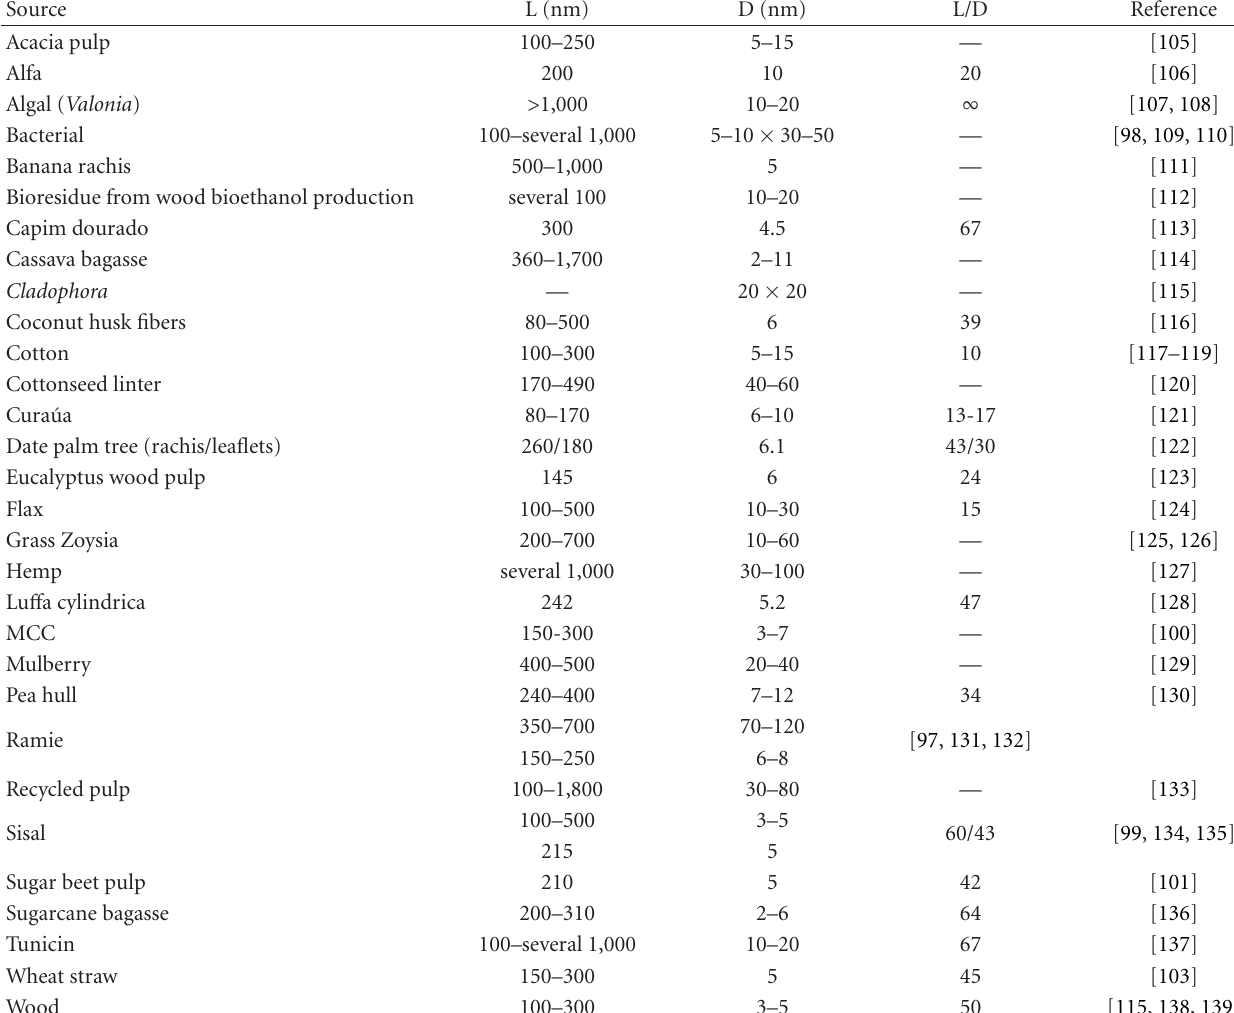
Table 1: Geometrical characteristics of cellulose nanocrystals from various sources: length (L), cross section (D), and aspect ratio